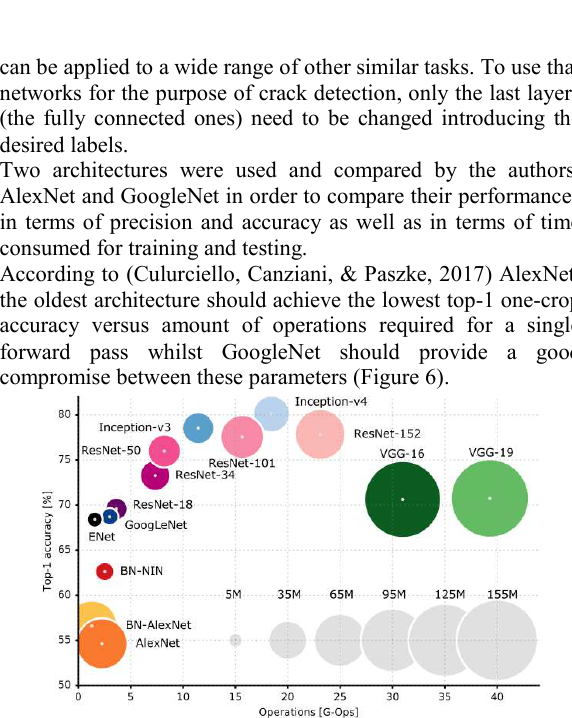
Figure 6: Comparison of different architectures (Culurciello, Canziani, & Paszke, 2017) .